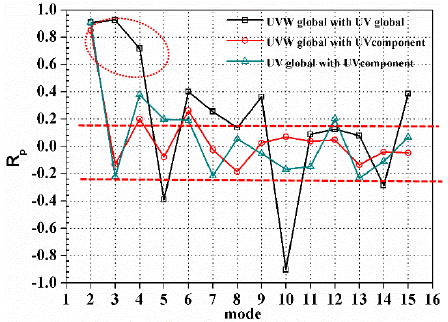
Figure 18. The velocity correlation of high-order modes from different decomposition dimensionalities at L/c = 1.1.